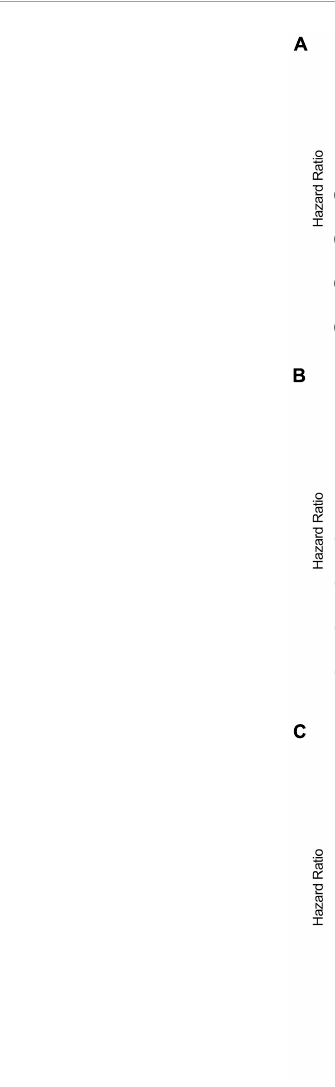
FIGURE3 Dose–response analyses on the associations of energy-adjusted consumption of (A) total fried foods, (B) deep-fried foods, and (C) pan-fried foods with the risk of pancreatic cancer, with the reference level set at 0 g/day. Hazard ratios were adjusted for age, sex, smoking status, alcohol consumption, BMI, aspirin use, history of diabetes, family history of pancreatic cancer, and energy intake from diet. The P for non-linearity were 0.043 for total fried food consumption, 0.013 for deep-fried food consumption, and 0.900 for pan-fried food